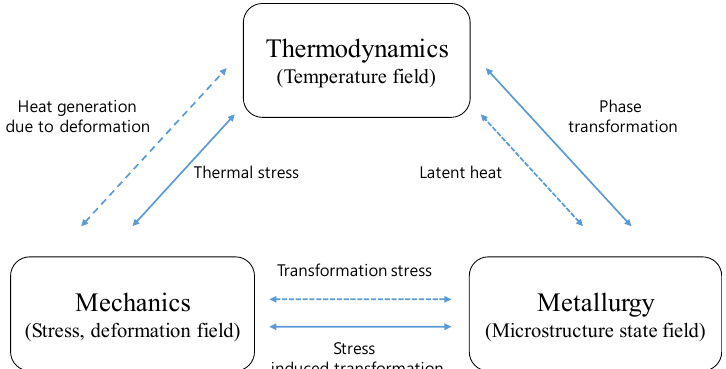
Figure 16. Schematic diagram coupling temperature, microstructure and stress. Table 10. Material properties of Al 6061 T6.